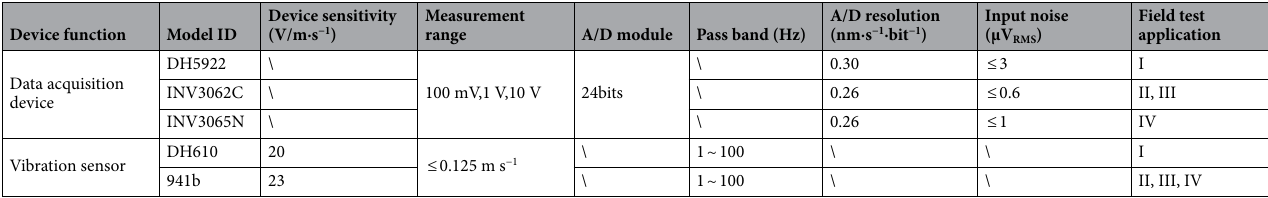
Table 1. Devices in field tests.